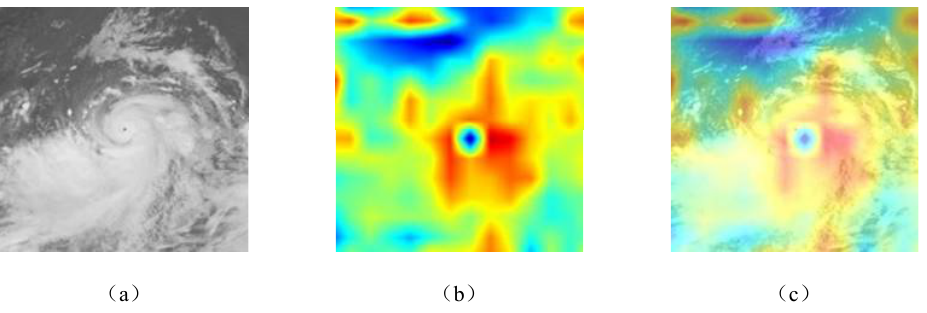
Figure 7. ( a ) The FY-4A satellite cloud of Typhoon 1909 at 08–07 09:00; ( b ) is the heat map obtained by passing through the ResNet model and convolving the last layer of the ResNet model; ( c ) is obtained by superimposing ( a ) and ( b ) together.